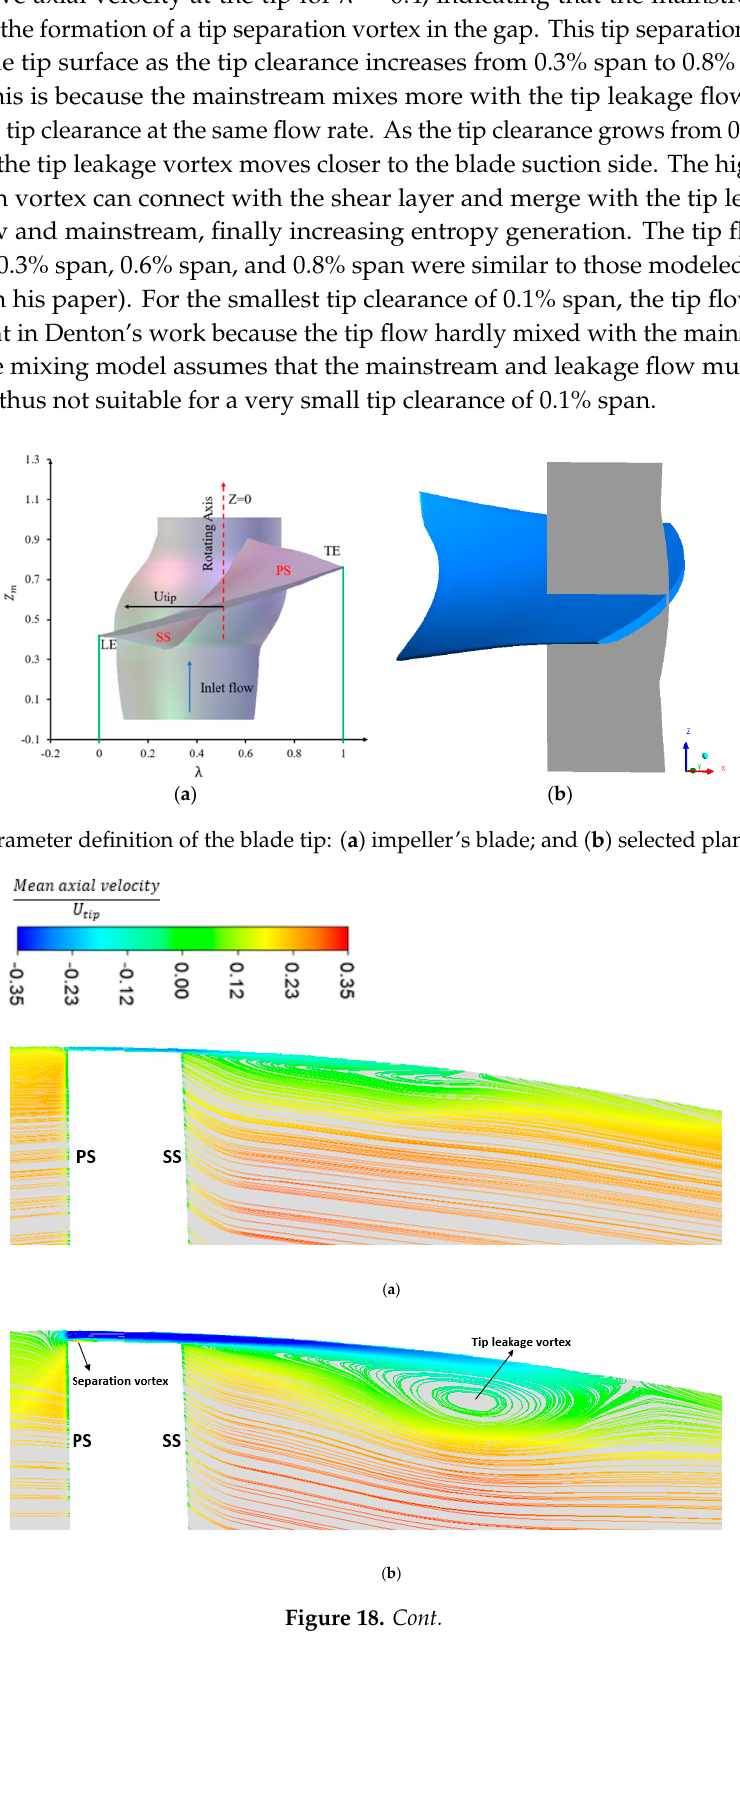
Figure 16. Distributions of 𝑆 (cid:3005)(cid:3014) (reflecting the turbulent entropy generation rate) along different spanwise surfaces of the impeller for varying tip clearance at φ = 0.354 (( a ) h = 0.1% span; ( b ) h = 0.3% span; ( c ) h = 0.6% span; and ( d ) h = 0.8% span)